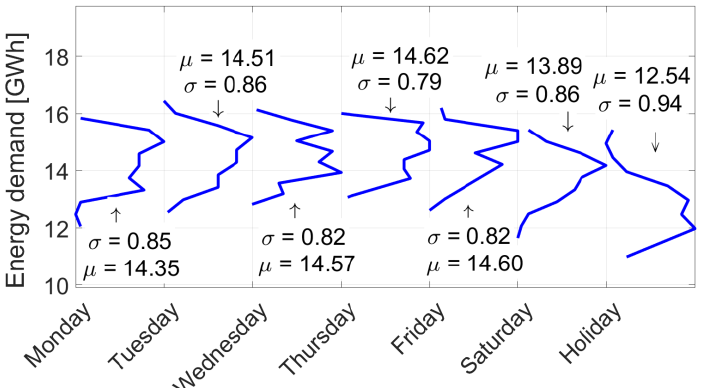
2020 Figure 9. Energy demand distribution for each type of day between 2016 and 2018. Energies , 13 , x FOR PEER REVIEW Figure 9. Energy demand distribution for each type of day between 2016 and 2018. Figure 9. Energy demand distribution for each type of day between 2016 and 2018.